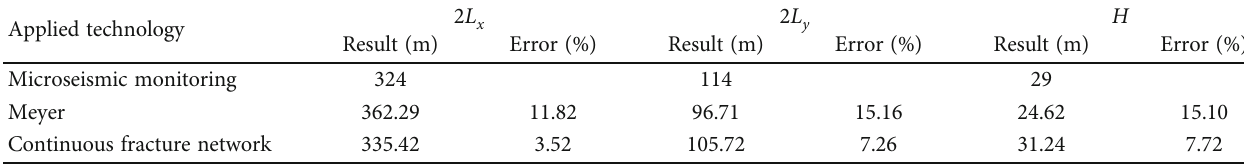
Table 4: Comparison of prediction results of well H03-11 by di ff erent technologies.